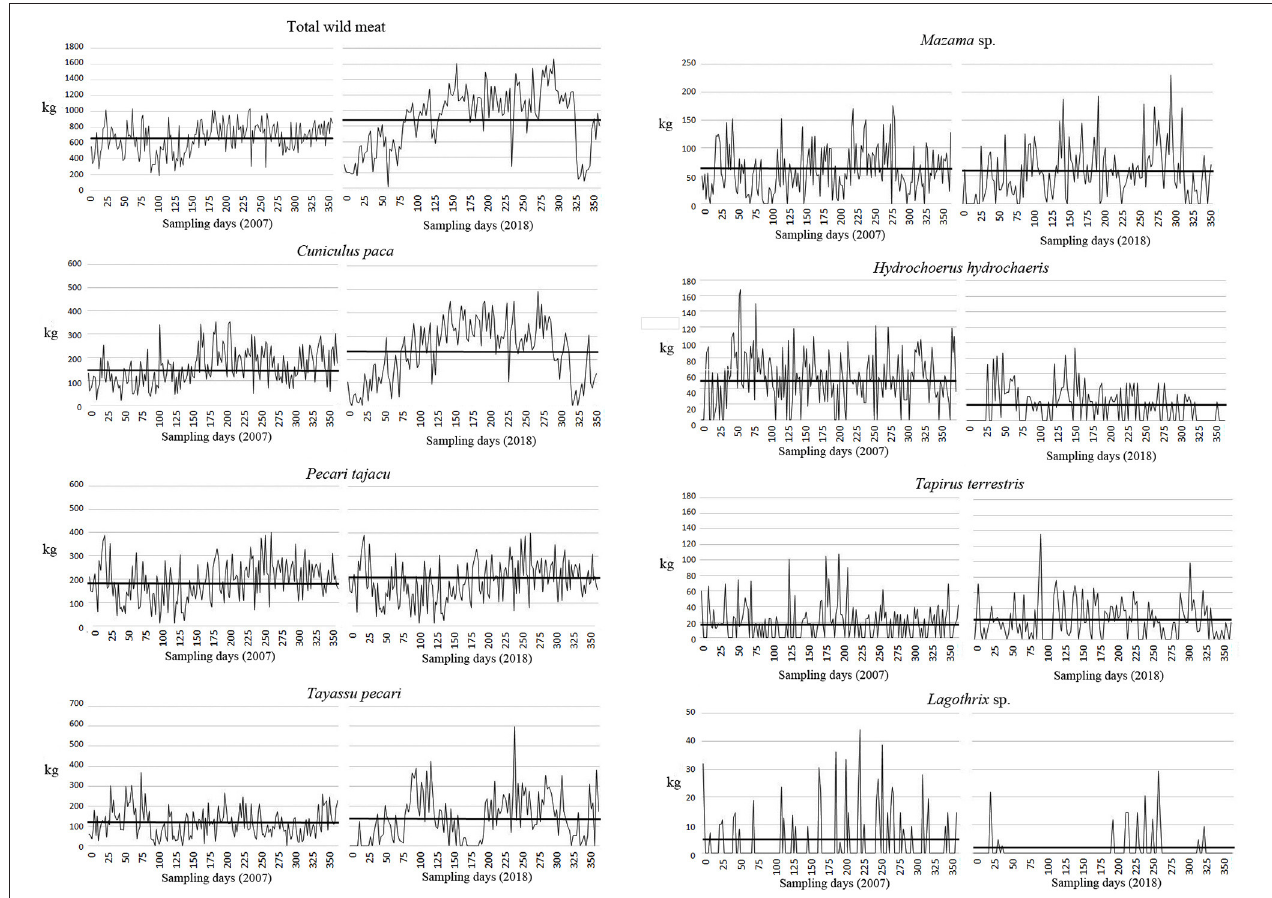
FIGURE 1 | Trends in the total amount of wild meat (in fresh-converted kilograms) and the amount of meat for the most traded species, Pecari tajacu , Cuniculus paca , Tayassu pecari , Mazama sp. Hydrochoerus hydrochaeris , Tapirus terrestris , and Lagothrix sp. in the Belén Market (Iquitos) in two 12-month surveys conducted in 2006–2007 and 2017–2018. Solid bold lines represent the average amount of wild meat (in fresh-converted kilograms) commercialized per species and